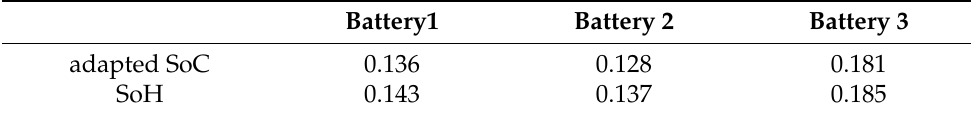
Table 19. Capacity fade of the control strategies for Case 1.